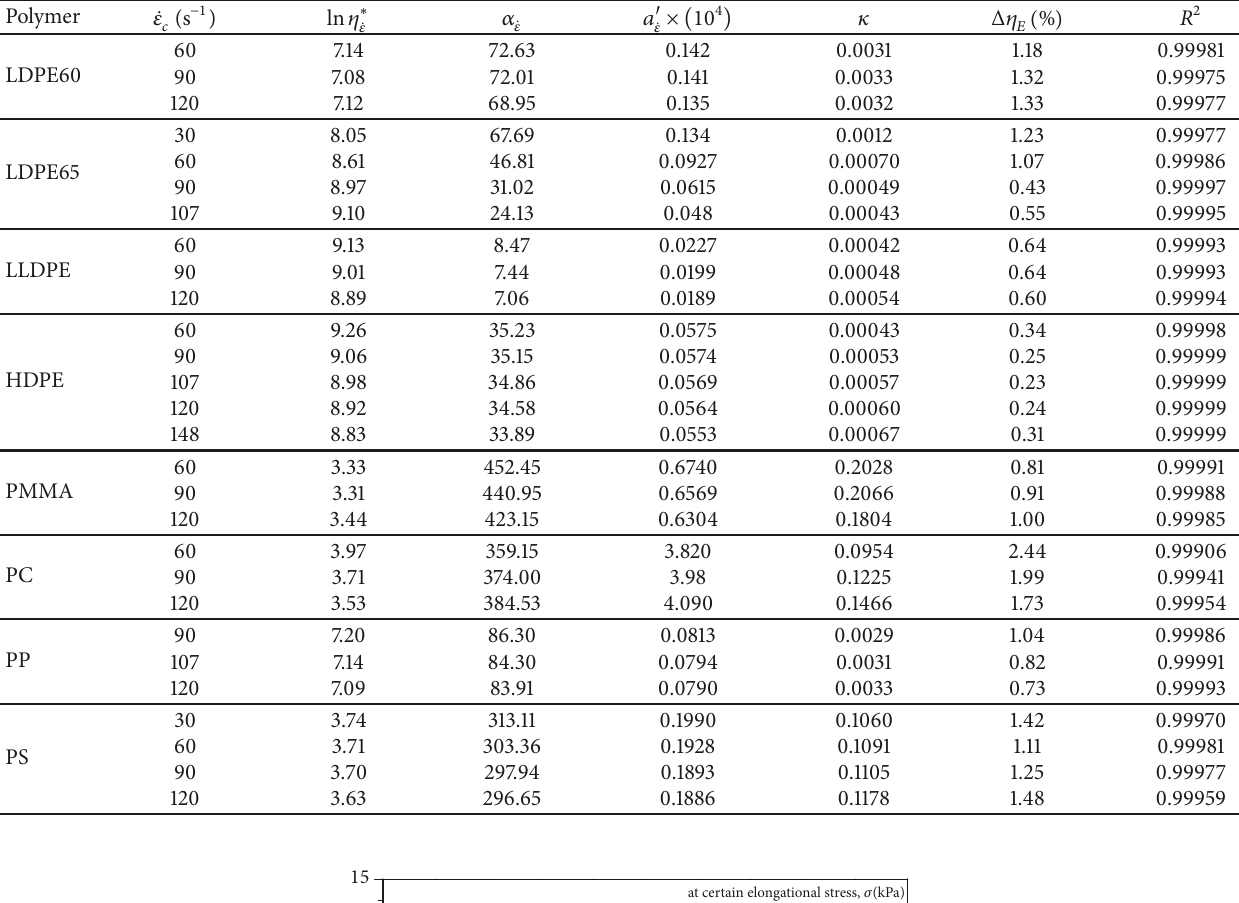
Table 3: Values of parameters of (7) evaluated for 𝜂 𝐸 at different elongational rates. Polymer